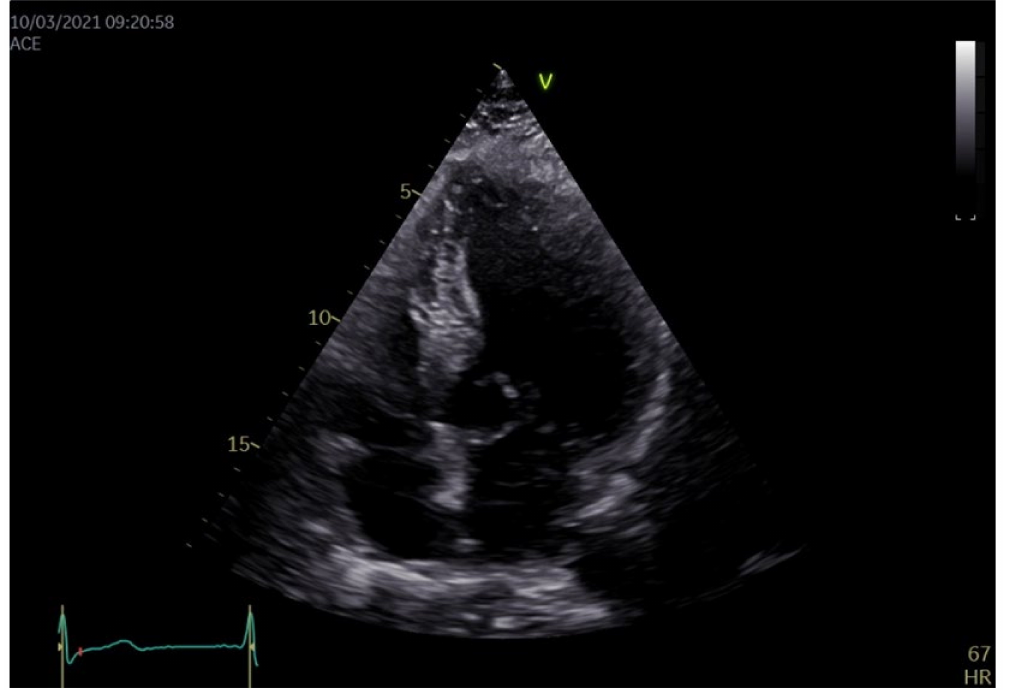
Figure 1. Transthoracic bidimensional echocardiography, 4 chamber view: a mitral valve with fibrosed leaflets, an elongated AML and SAM of both AML and PML, creating an anteriorly deviated “funnel”.